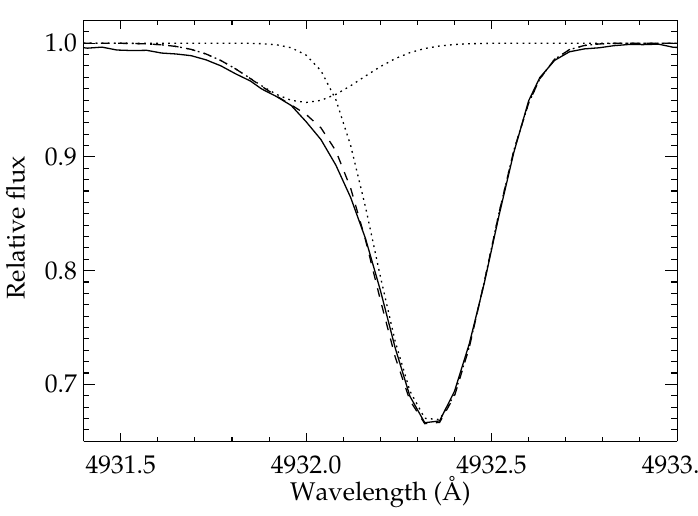
Fig. 6. Gaussian decomposition of the C I line λ = 4932.05 (cid:23)A. Solid line { the observed pro(cid:12)le, dotted line { the components at λ = 4931.97 (cid:23)A with W (cid:21) = 1 . 7 pm and FWHM = 37 pm, and at λ = 4932.34 (cid:23)A with W (cid:21) = 12 . 2 pm and FWHM = 35 pm. The sum of these components is indicated by the dashed